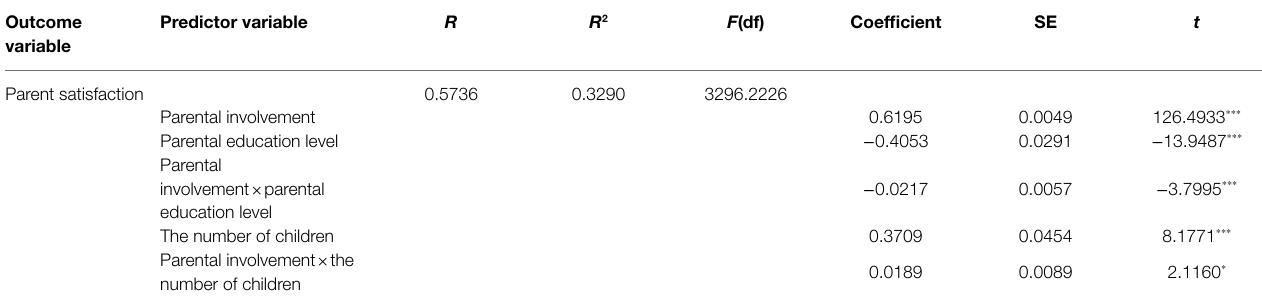
TABLE 6 | Standardized bootstrap moderating effect test. Outcome